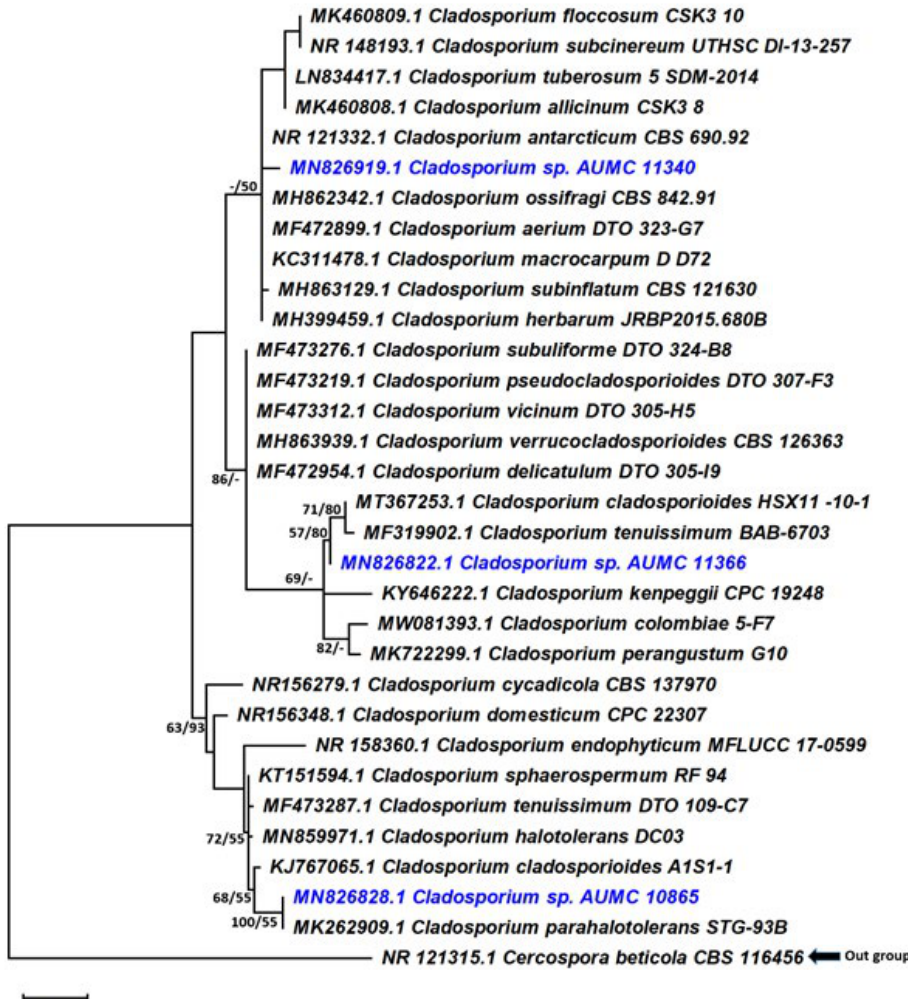
Fig. 1. Phylogenetic tree generated from MP analysis based on alignment of ITS sequences of Cladosporium isolates AUMC 10865, AUMC 11340 and AUMC 11366 with the most similar sequences belonging to Cladosporium in GenBank database. Sequences from this study are in blue color. Bootstrap support values (100 replications) for ML/MP combination ≥50% are indicated at the respective nodes. The tree was rooted to Cercospora beticola CBS 116456 as